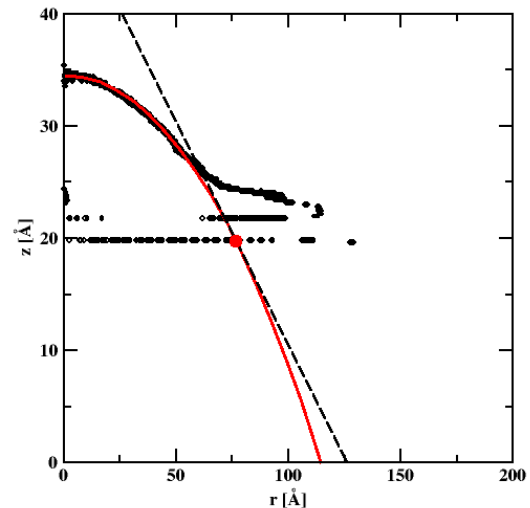
Figure 12. The spherical droplet contour calculated for the water–silicon dioxide surface system. The circles denote the position of the water density profile with value 0.5 ± 0.03 g / cm 3 . The thick red line denotes the droplet profile obtained by applying the fitting procedure. The dashed line denotes the line tangent to the drop that meets the bottom of the nanodroplet at the big red point.